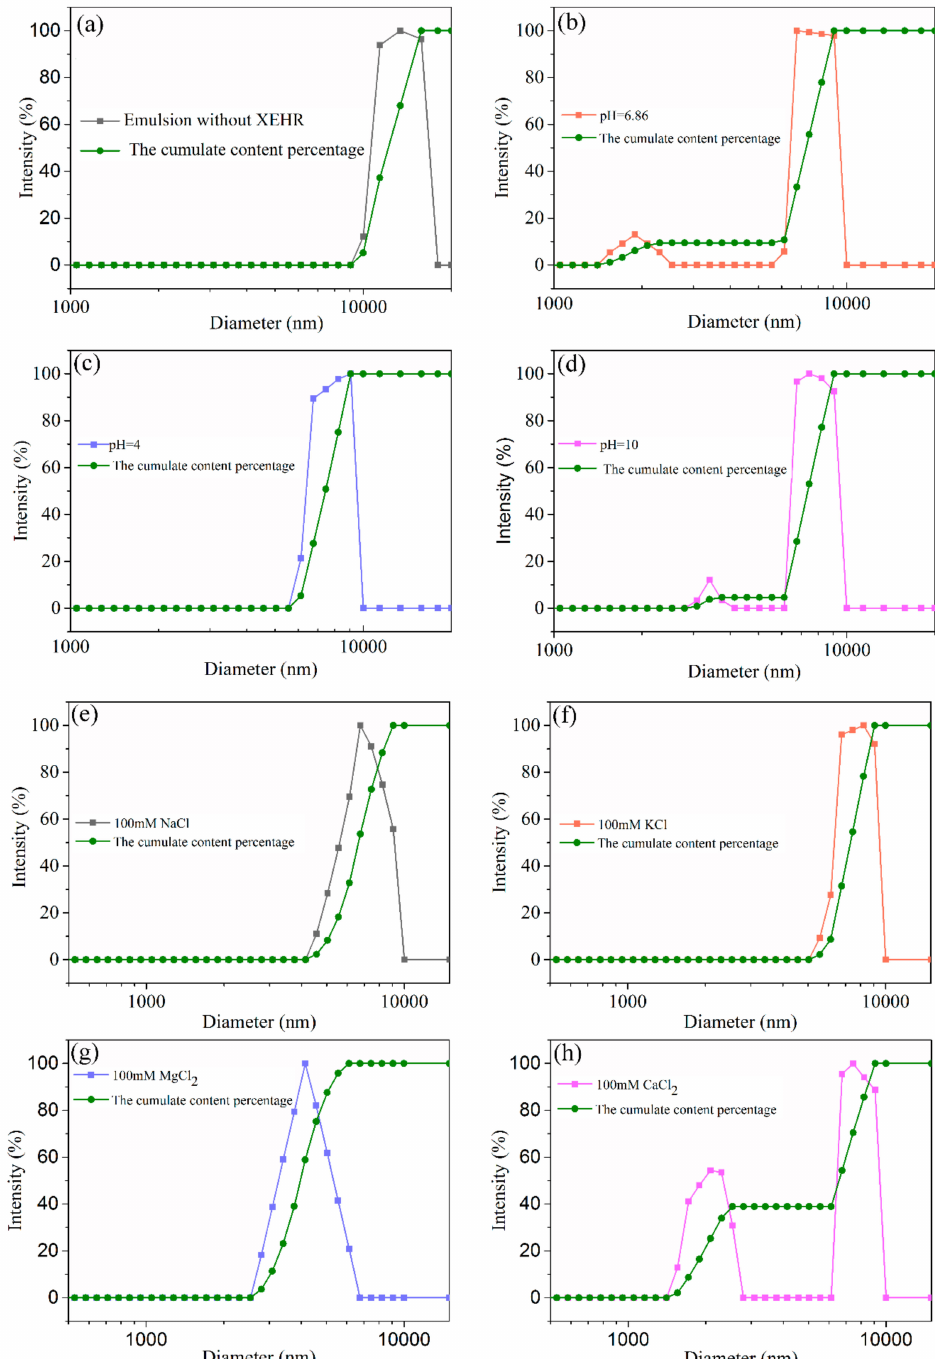
Figure 6. The particle size distribution curves and cumulative content percentage curves of emulsions under di ff erent pH and di ff erent salt conditions. ( a ) Emulsion without the XEHR, ( b ) emulsion pH = 6.86, ( c ) emulsion pH = 4, ( d ) emulsion pH = 10, ( e ) emulsion containing NaCl 100 mM, ( f ) emulsion containing KCl 100 mM, ( g ) emulsion containing MgCl 2 100 mM, ( h ) emulsion containing CaCl 2 100